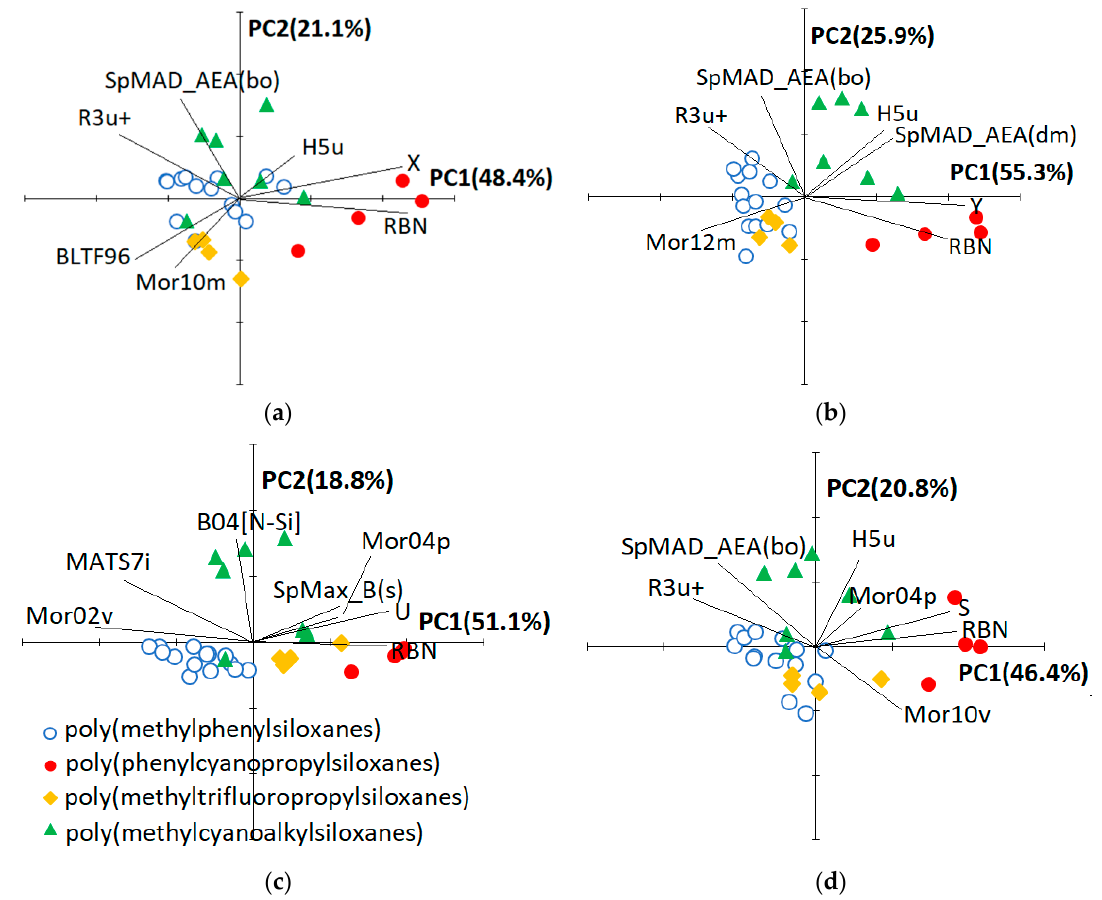
Figure 4. Projection of columns and variables of QSRRs established for X ( a ), Y ( b ), U ( c ) and S ( d ) in the plane of the first two principal components .